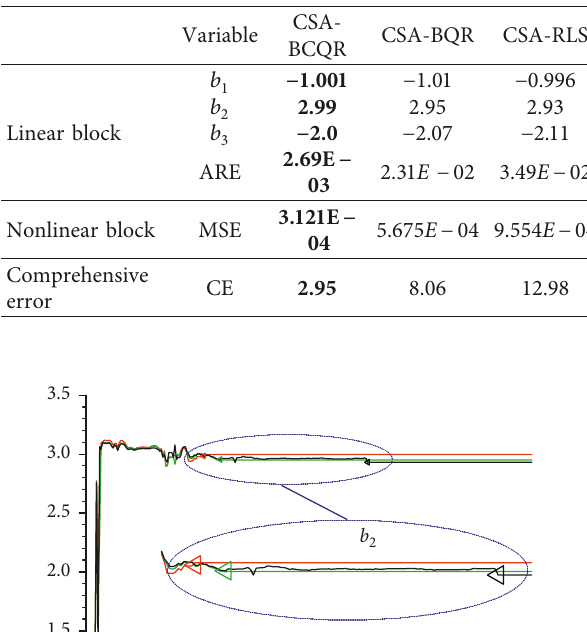
Table 1: Comparison among CSA-BCQR, CSA-BQR, and CSA- RLS in the numerical simulation.